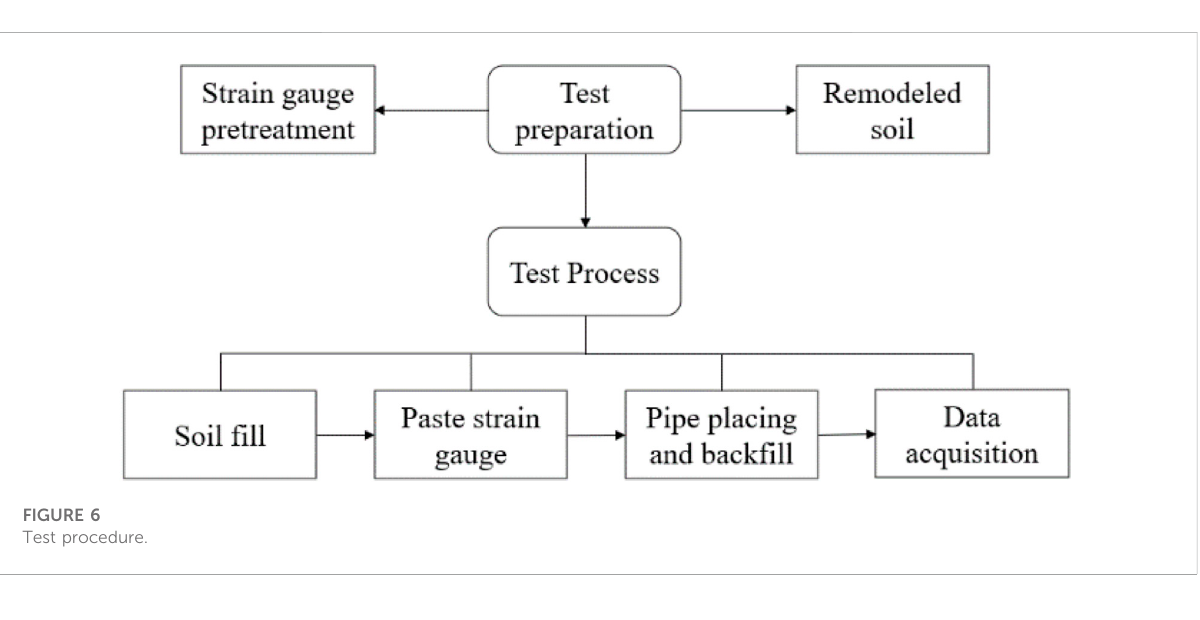
FIGURE 6 Test procedure.